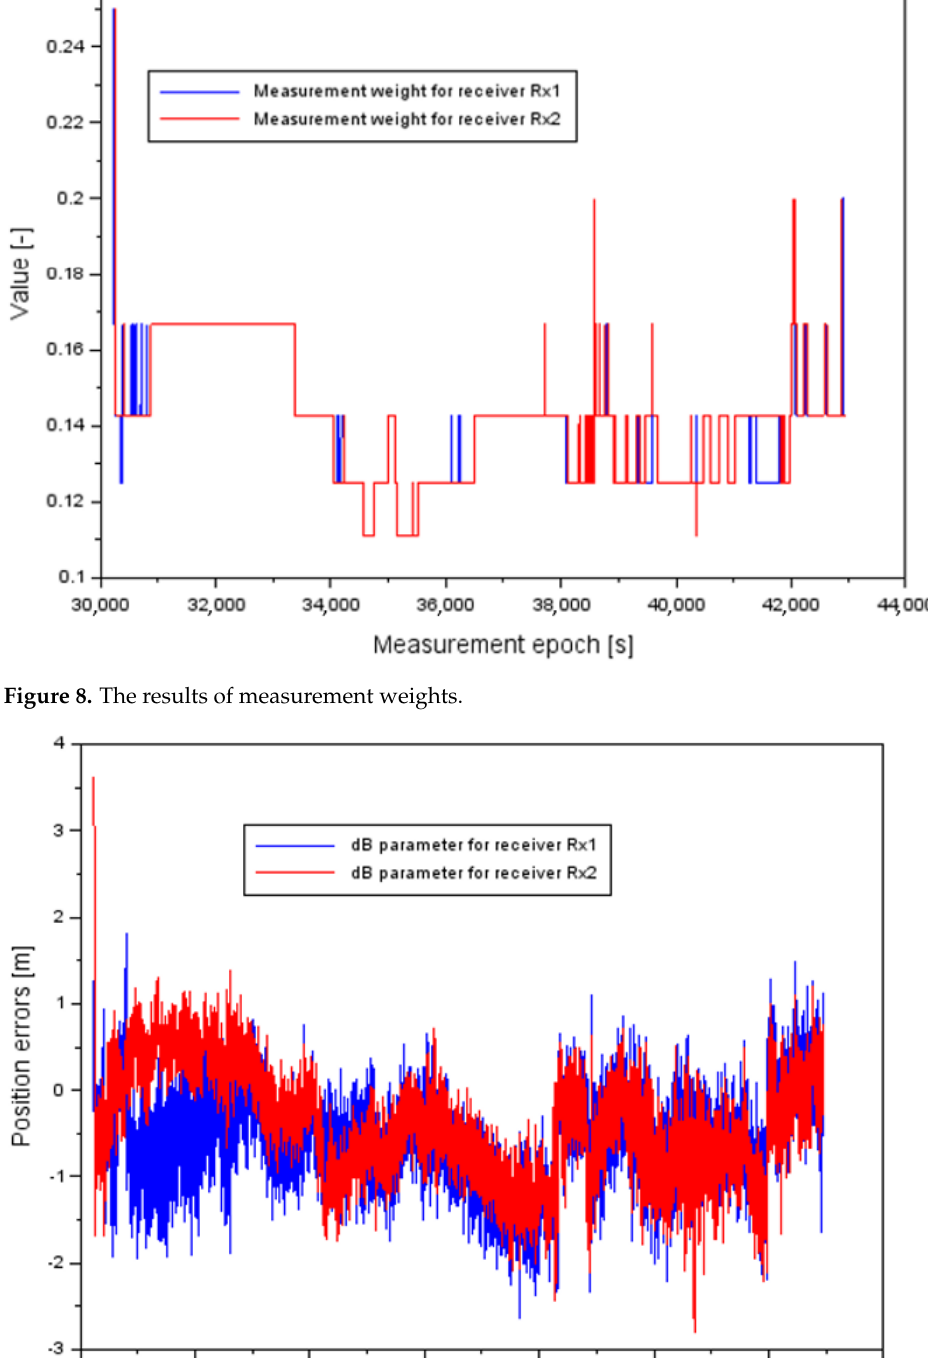
Figure 10. The results of 𝑑𝐿 position errors for 𝑅𝑥1 and 𝑅𝑥2 receivers.